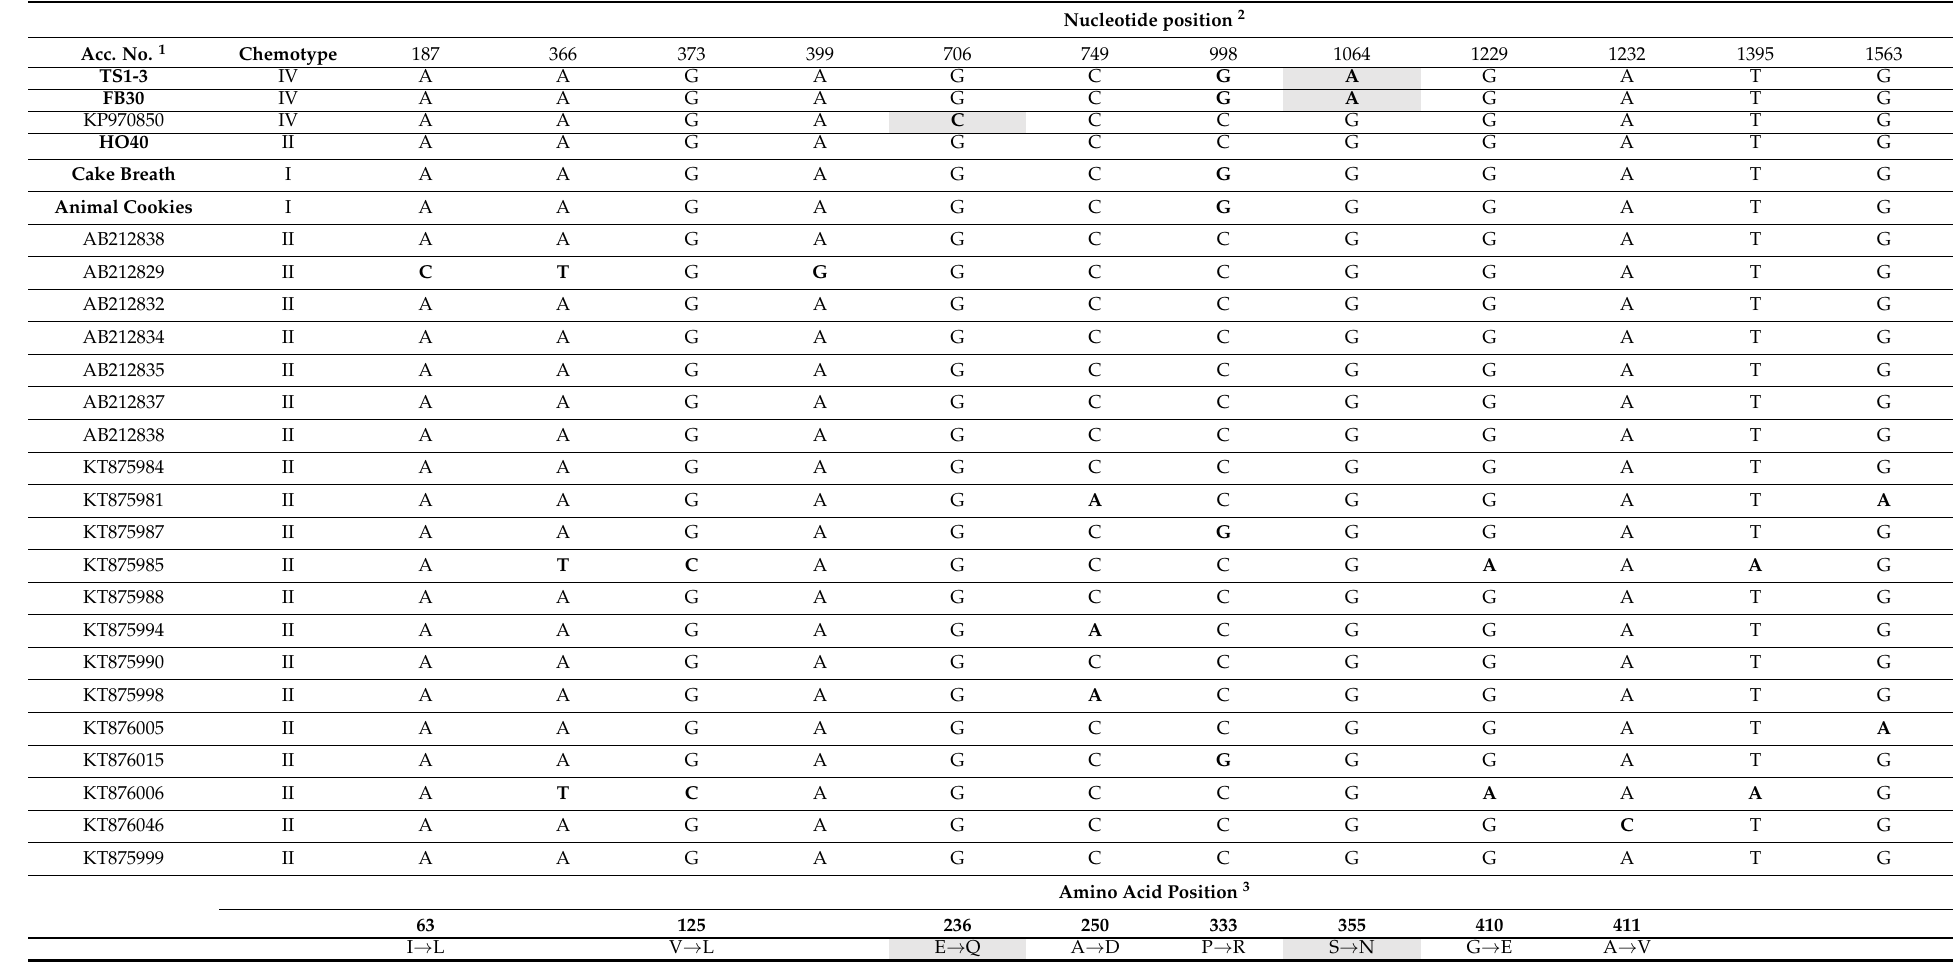
Table 2. Single nucleotide polymorphisms among tetrahydrocannabinol acid synthase (THCAS) genes from selected